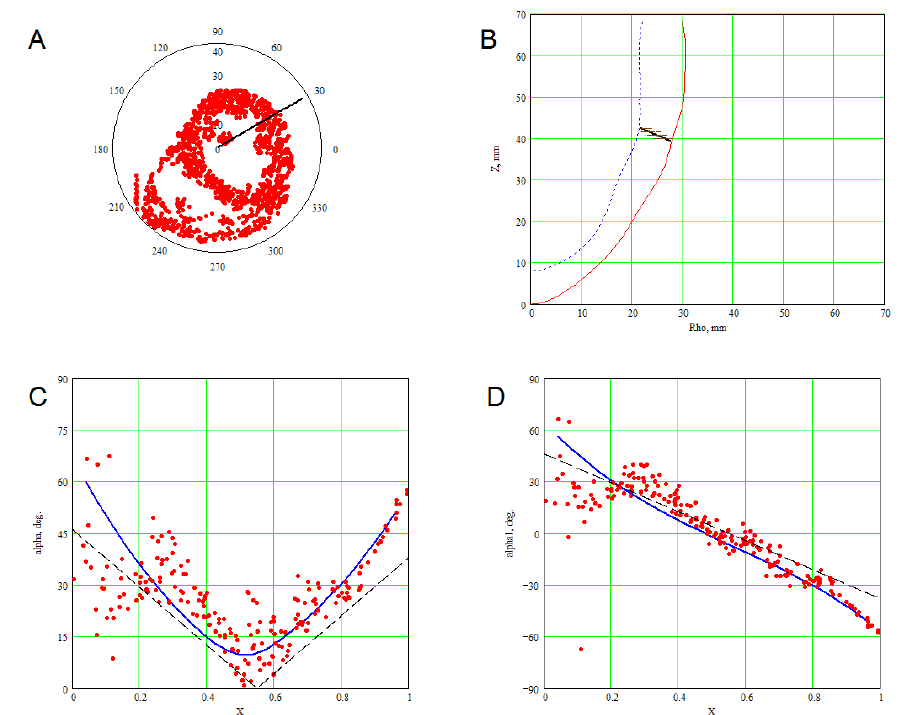
Figure 8. Fiber angles in the model and experimental data. The LV free wall in the middle area ( ψ = 25 ◦ ) is shown. The conventional signs are the same as in Figure 7.